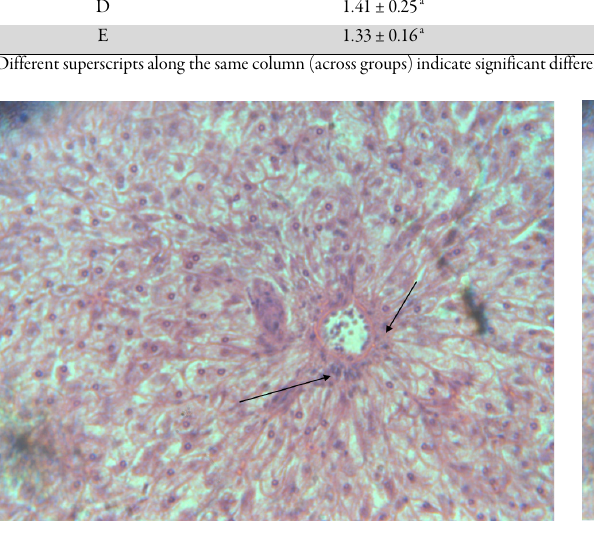
Fig. 2. Group B H&E X400 LIVER showing normal hepatocytes arranged in cords with central vein filled with red blood cells